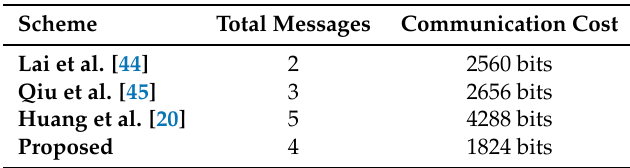
Table 4. Communication